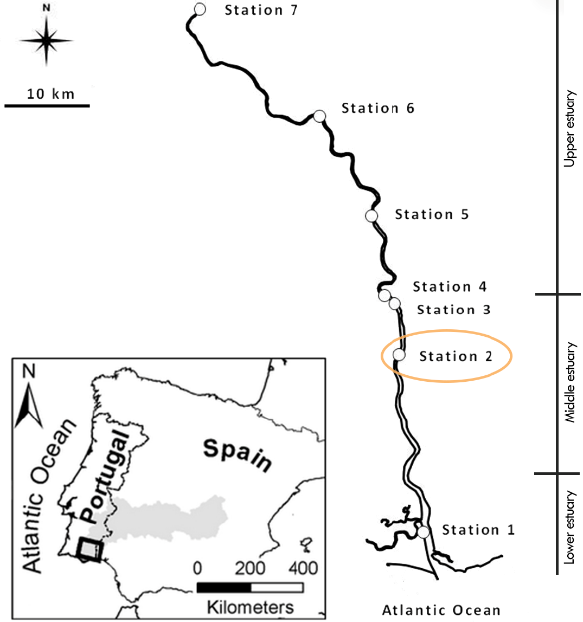
Figure 1. Location of the Guadiana estuary in SW Iberian Peninsula and all the seven sampling stations. Station 2, where Tenellia adspersa was found, is highlighted. Adapted from Seyer et al. (2017).